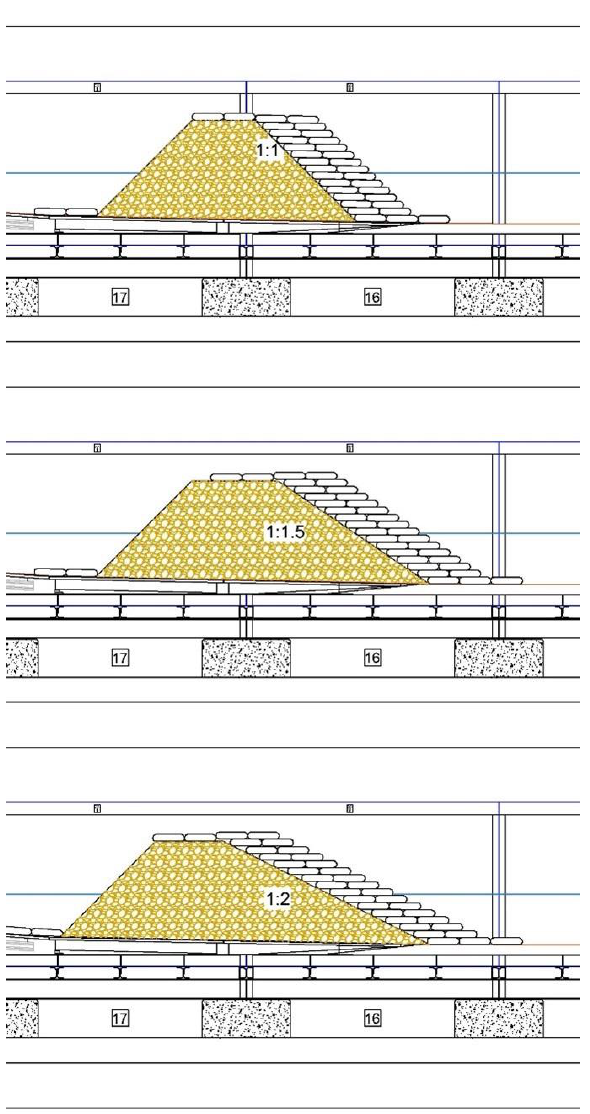
Figure 4. Coastal adherent revetments of the geotextile sand container. Longitudinal views of GSCs with seaside slopes of 1:1 ( upper panel ), 1:1.5 ( middle panel ) and 1:2 ( lower panel ).